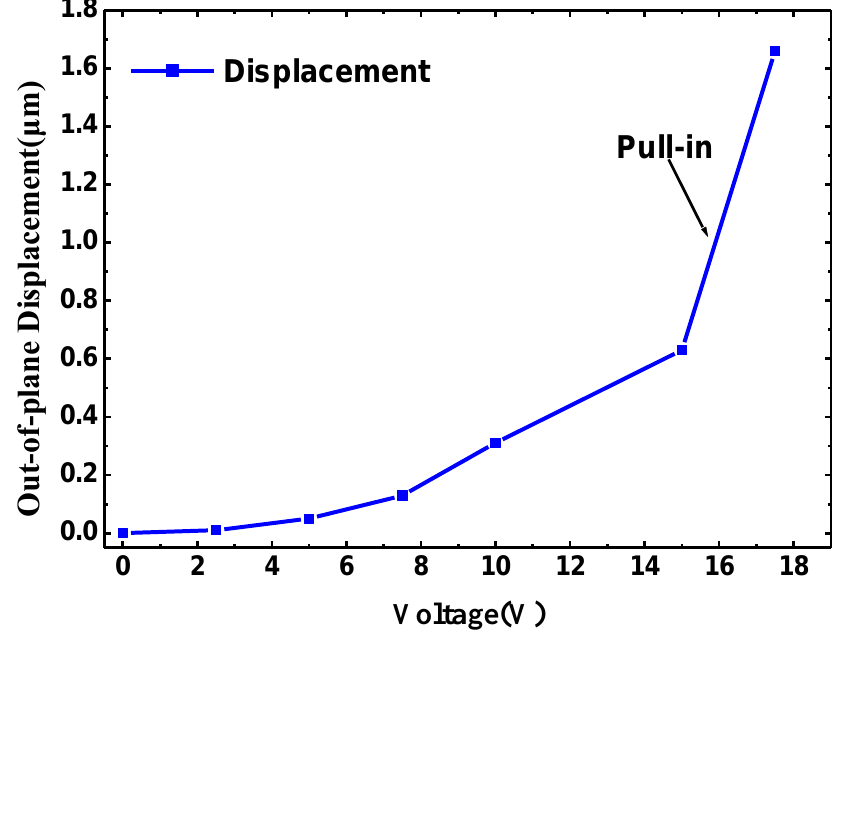
Figure 10. Test results of out-of-plane displacement versus voltage in the electrostatic attractive